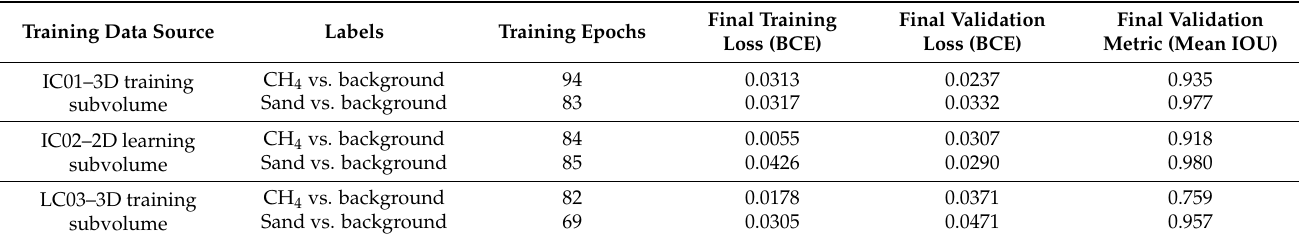
Table 4. Single- and multi-axis 2D multilabel U-Net training